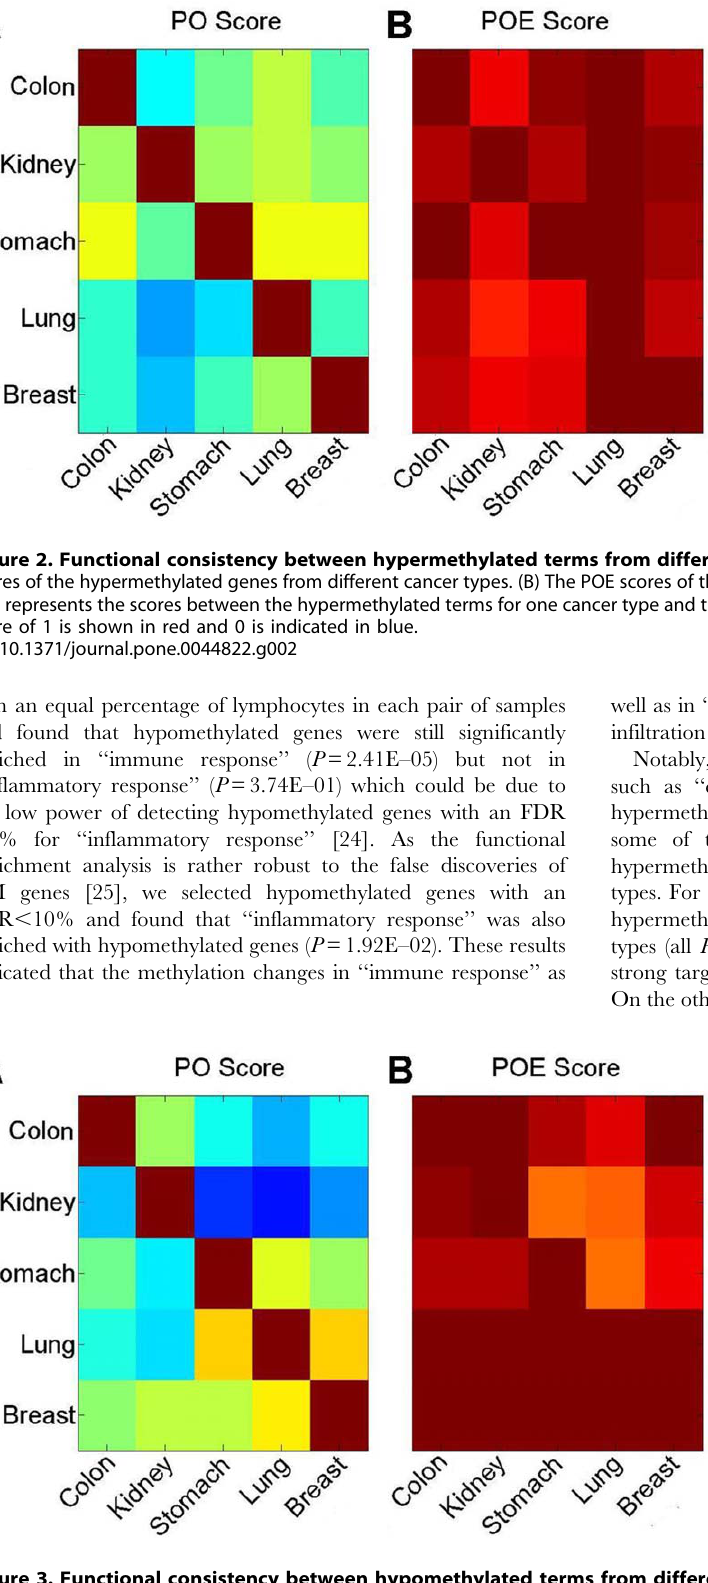
Figure 3. Functional consistency between hypomethylated terms from different cancer types with PO and POE scores. (A) The PO scores of the hypomethylated genes from different cancer types. (B) The POE scores of the hypomethylated genes from different cancer types. Each row represents the scores between the hypomethylated terms for one cancer type and the hypomethylated terms for the other cancer types. A POE score of 1 is shown in red and 0 is indicated in blue.